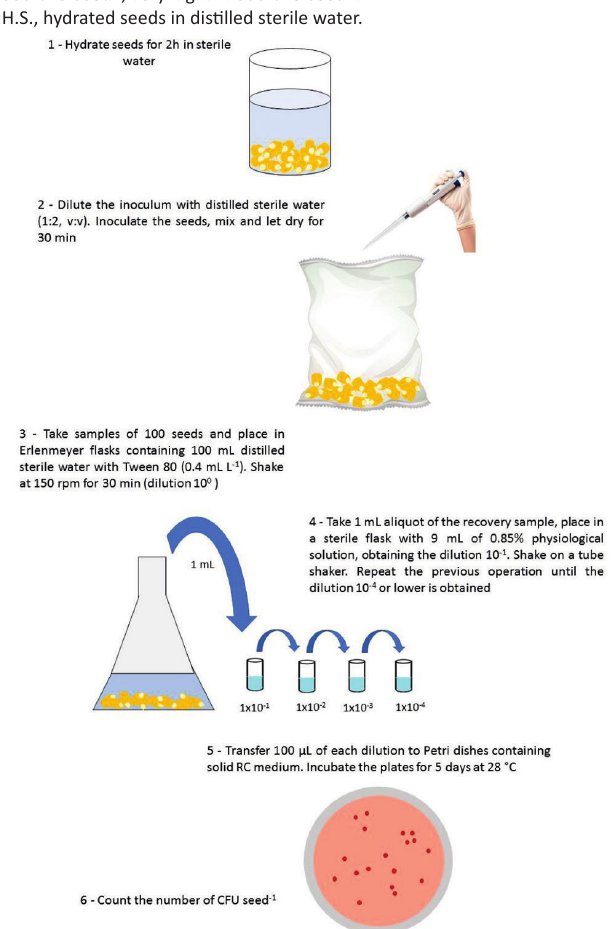
Fig. 1. Schematic outline of the method for estimating the recovery and counting of viable cells of Azospirillum from inoculated maize